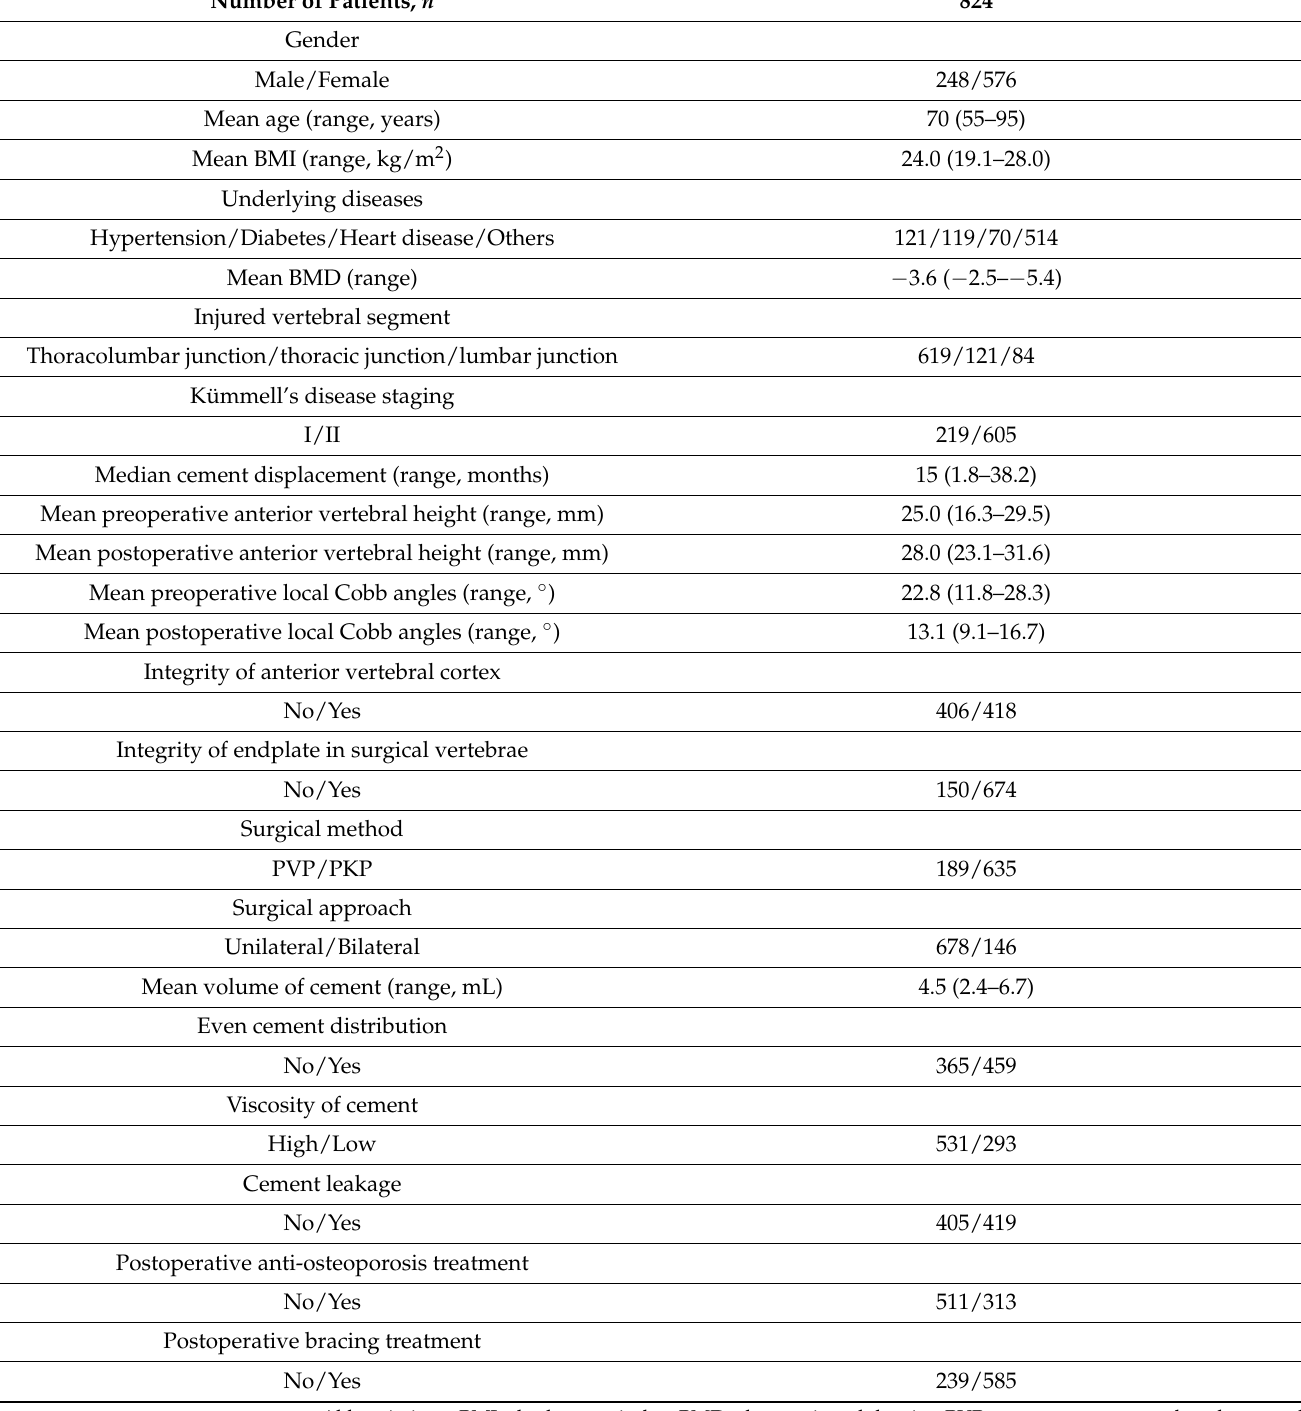
Table 1. Characteristics of patient